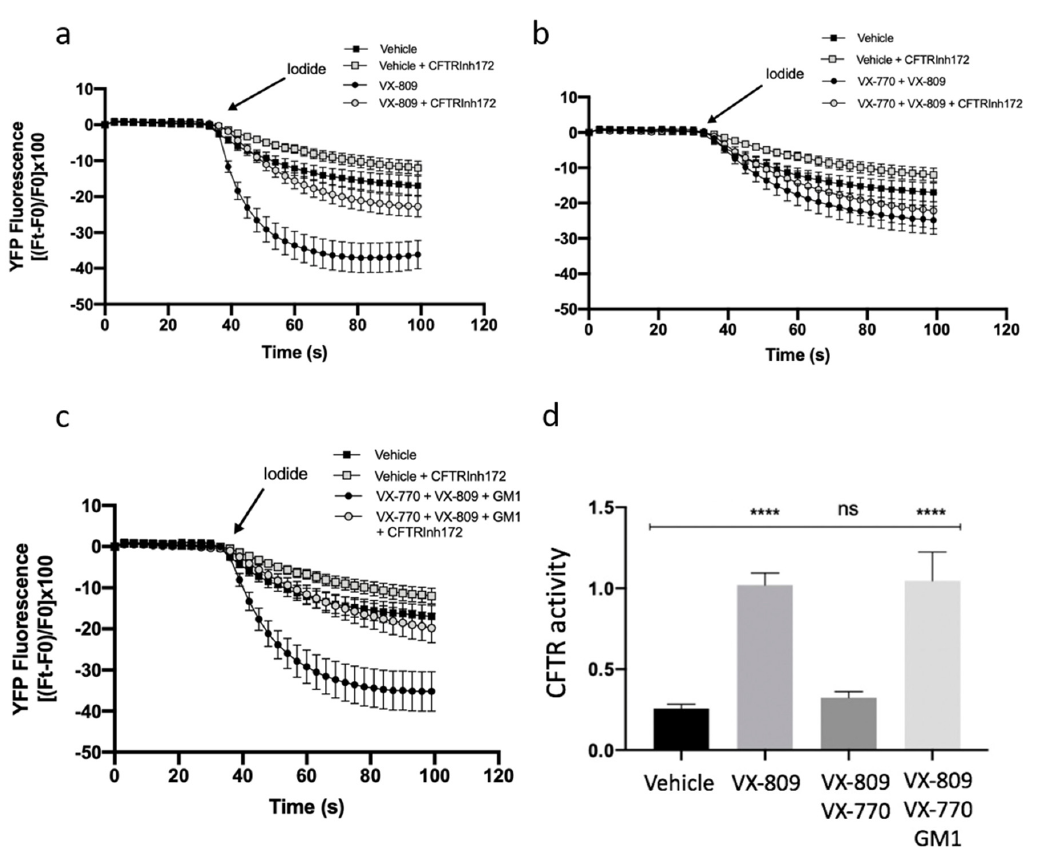
Figure 5. GM1 reduces the negative effect of VX-770 on CFTR-dependent chloride efflux in CFBE41o - -YFP-F508del cells. CFTR-dependent chloride efflux was assayed by single cell fluorescence imaging analysis of YFP fluorescence quenching by iodide, stimulated by forskolin (20 µM), in the presence or absence of CFTRInh-172 (10 µM). Each point in the representative traces is the mean ± SEM of data coming from all cells in the field (5–10 cells) ( a ) Representative traces showing iodide influx in control conditions (vehicle), or after 48 h incubation with 1 µM VX-809; ( b ) Representative traces showing iodide influx in control condition (vehicle), or after 48 h incubation with 5 µM VX-770 in combination with 1 µM VX-809; ( c ) Representative traces showing iodide influx in control condition (vehicle), or after 48 h incubation with 5 µM VX-770 in combination with 1 µM VX-809 and 50 µM GM1. ( d ) The YFP fluorescence decay rate measured in each cell was calculated by fitting data of time courses by an exponential function, both in the absence and presence of CFTRInh-172. CFTR activity was obtained by subtracting the data of cells treated with CFTR inhibitor 172 from those of cells in the absence of the inhibitor. Each bar corresponds to the mean ± SEM of data points coming from at least three different experiments (5–10 different cells/each experiment). Statistical comparisons were made using a nonparametric ANOVA test (* p < 0.05, ** p < 0.01, *** p < 0.001, and **** p < 0.0001).